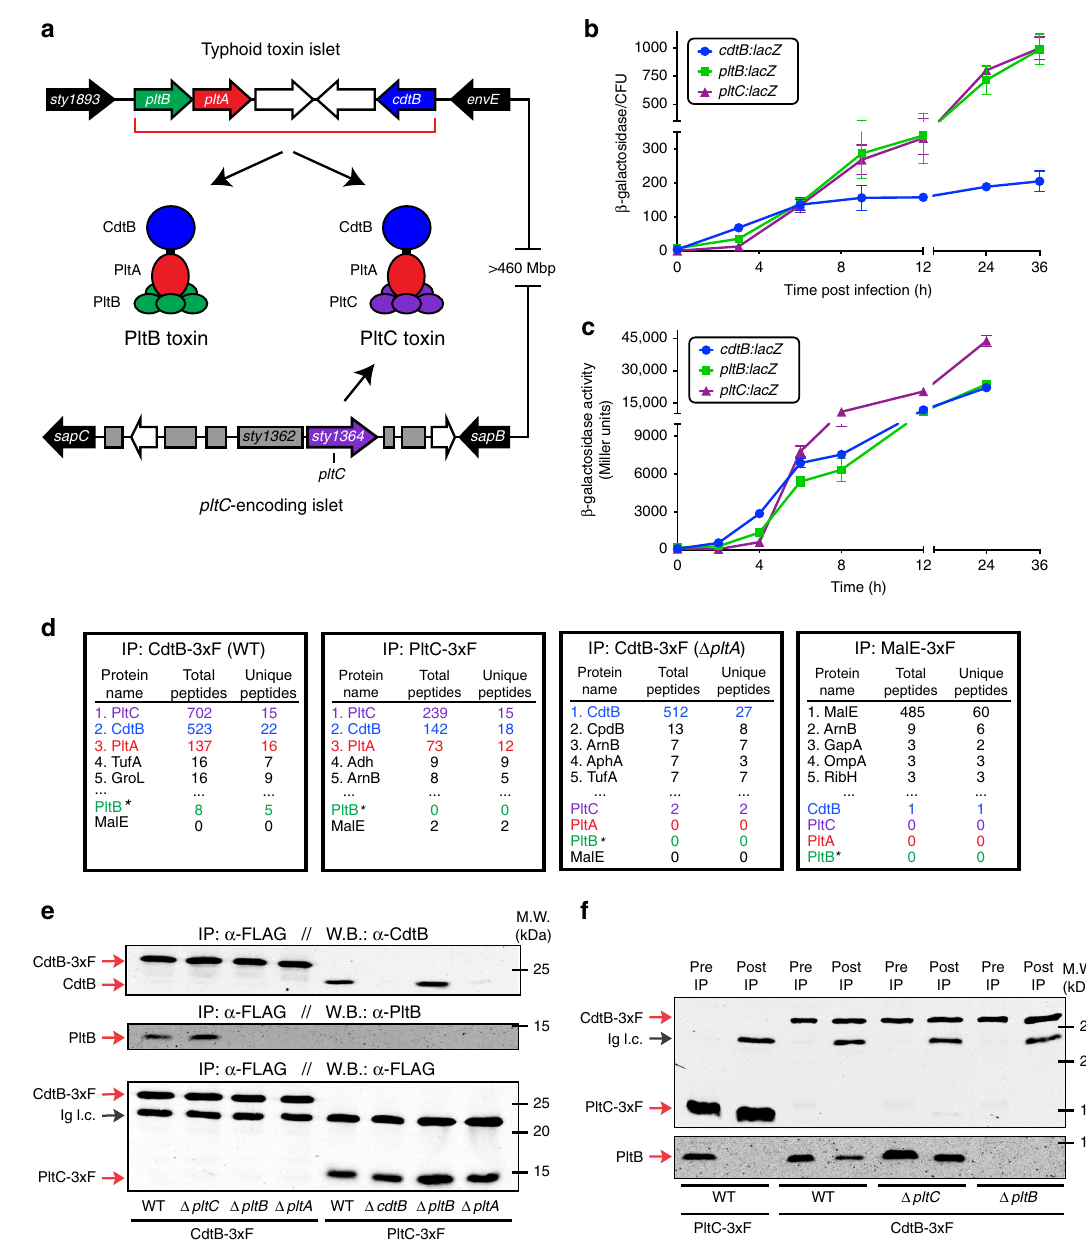
Fig. 1 S . Typhi produces two distinct typhoid toxins with common active but different delivery subunits. a Illustration of the S . Typhi typhoid toxin genomic locus, as well as a distant locus that encodes pltC ( sty1364 ), an orphan pertussis-like toxin delivery subunit that exhibits homology to pltB . b , and c Expression of pltC , pltB and cdtB over time under conditions that stimulate typhoid toxin gene expression. The β -galactosidase activity in the pltC : lacZ , pltB : lacZ and cdtB : lacZ S . Typhi reporter strains was measured at the indicated time points following infection of Henle-407 cells b or growth in TTIM medium c . Values indicate the mean ±S.D. for three independent samples. d Interaction of PltC with PltA/CdtB in S . Typhi grown in TTIM. Cell lysates from S . Typhi strains encoding cdtB -3xFLAG, pltC -3xFLAG, cdtB -3xFLAG (in Δ pltA background), or malE -3xFLAG were immunoprecipitated with an anti-FLAG antibody and interacting proteins were identi fi ed using LC/MS/MS. For each sample the number of peptides for the fi ve most abundant proteins recovered and for all typhoid toxin subunits (color-coded according to panel a ) are shown. *Detection of PltB with the LC – MS/MS protocol even for puri fi ed typhoid toxin preparations is inef fi cient. e S . Typhi produces both PltB- and PltC-typhoid toxins within infected human cells. Henle-407 cells were infected with S . Typhi wild type or the indicated mutant strains encoding 3xFLAG epitope-tagged CdtB or PltC (as indicated) and 24 hs post-infection the interaction of the indicated toxin components were probed by co-immunoprecipitation and western blot analysis. f PltB forms a complex with CdtB, but not with PltC. The interaction of the indicated toxin components in cell lysates of the indicated strains encoding 3xFLAG epitope tagged CdtB or PltC were probed by anti- FLAG co-immunoprecipitation and western blot analysis. Whole cell lysates (Pre IP) and immunoprecipitated samples (post IP) were probed using an anti- FLAG antibody as a control (top blot) and an anti-PltB antibody (bottom blot) to identify PltB interactions with CdtB or PltC in the indicated strains. Ig. l. c.: Immunoglobulin light chain detected by the secondary antibody. Source data are provided as a Source Data fi